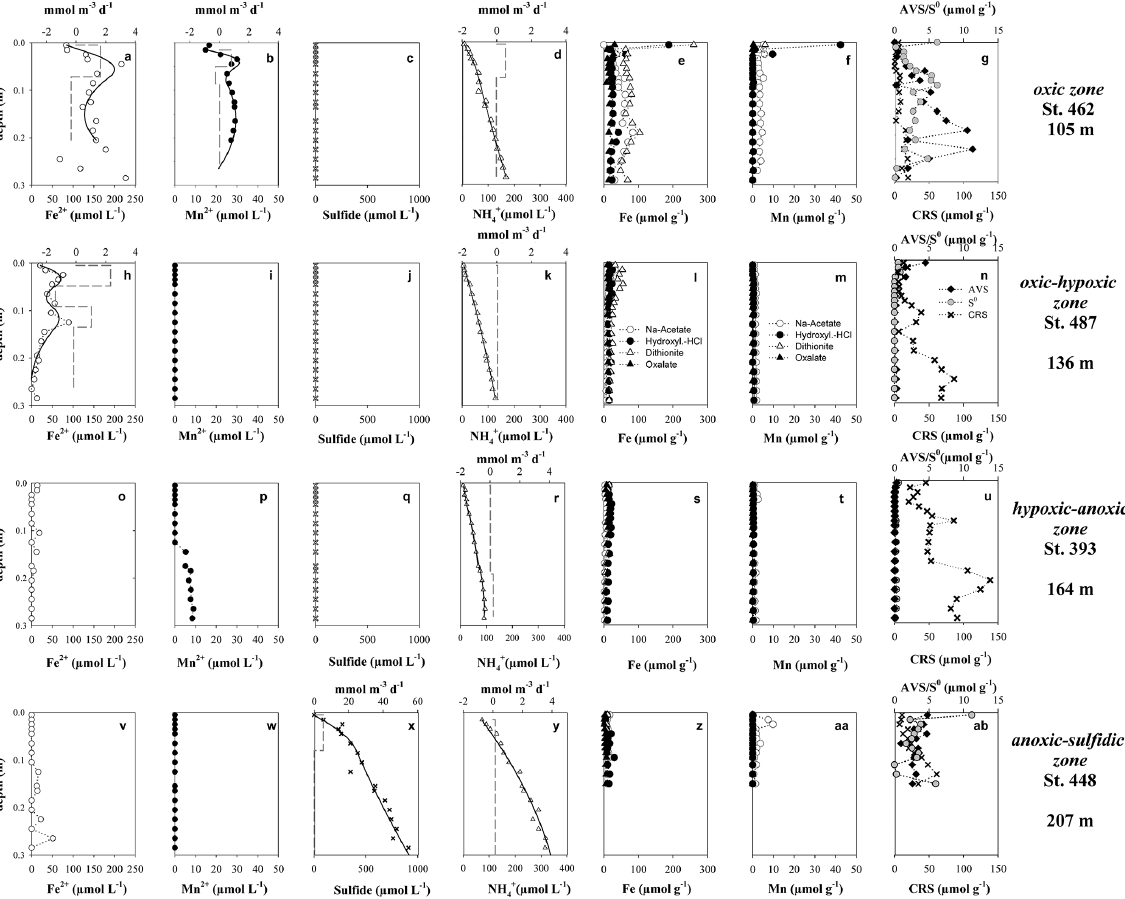
Figure 7. Distribution of reduced porewater species and oxidized and reduced solid-phase iron and sulfur species along the depth transect in the upper 30cm of the sediment (symbols with dotted lines). Solid lines are the model results and dashed lines represent production and consumption